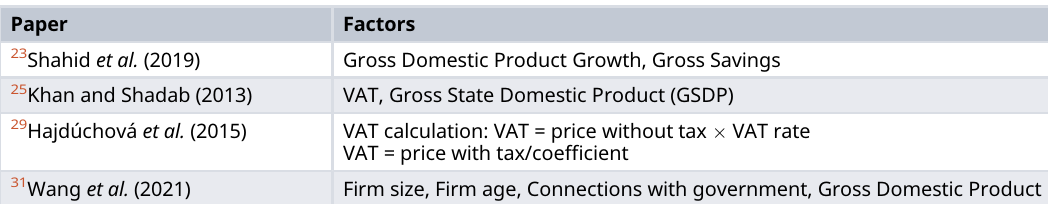
Table 4. Digital taxation factors related to frugal